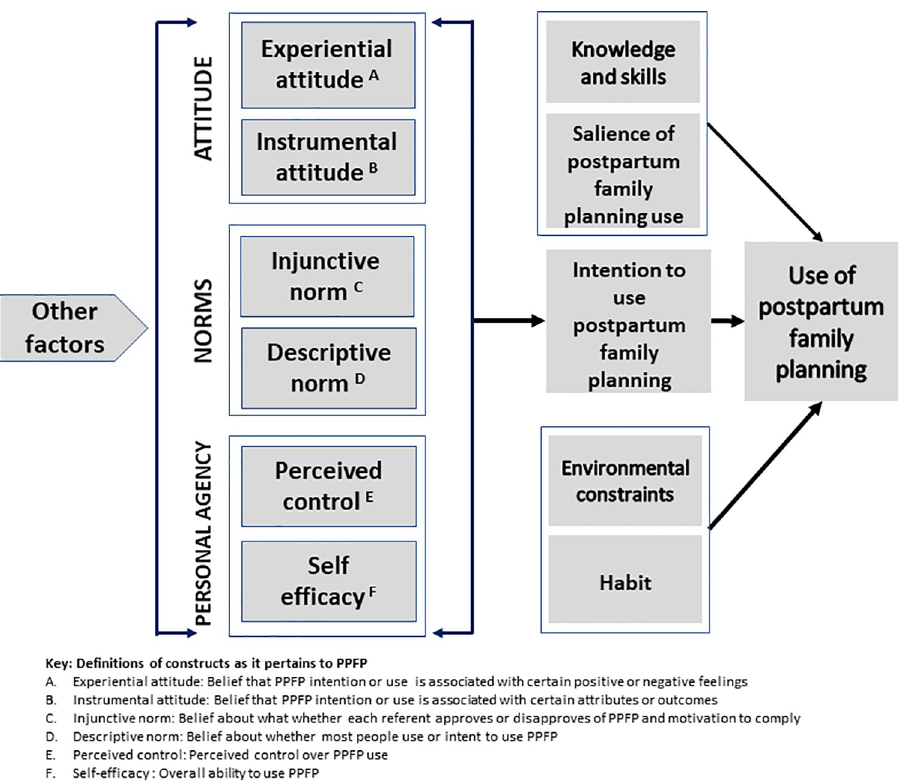
Fig 1. Integrated behavioral model of postpartum family planning